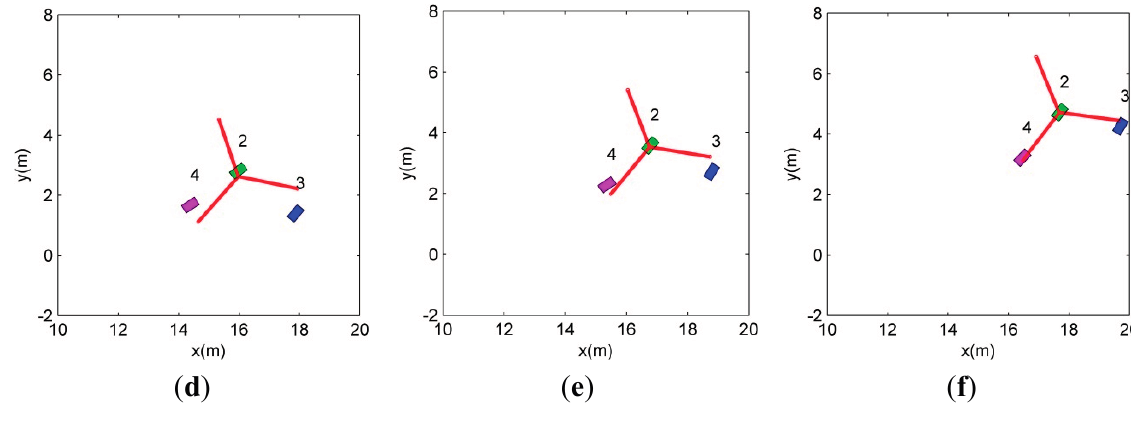
Figure 6. The details of the replacement of the leader.